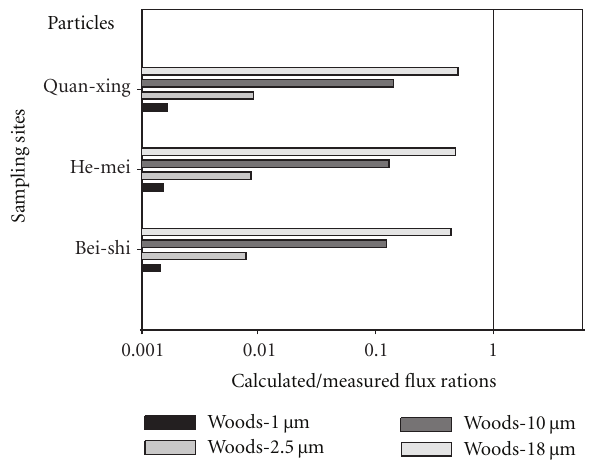
Figure 2: It displays the average calculated/modeled ratios results for ambient air particles by using Woods models for various parti- cles sizes (1.0 μ m, 2.5 μ m, 10 μ m, and 18 μ m) at three sampling sites.